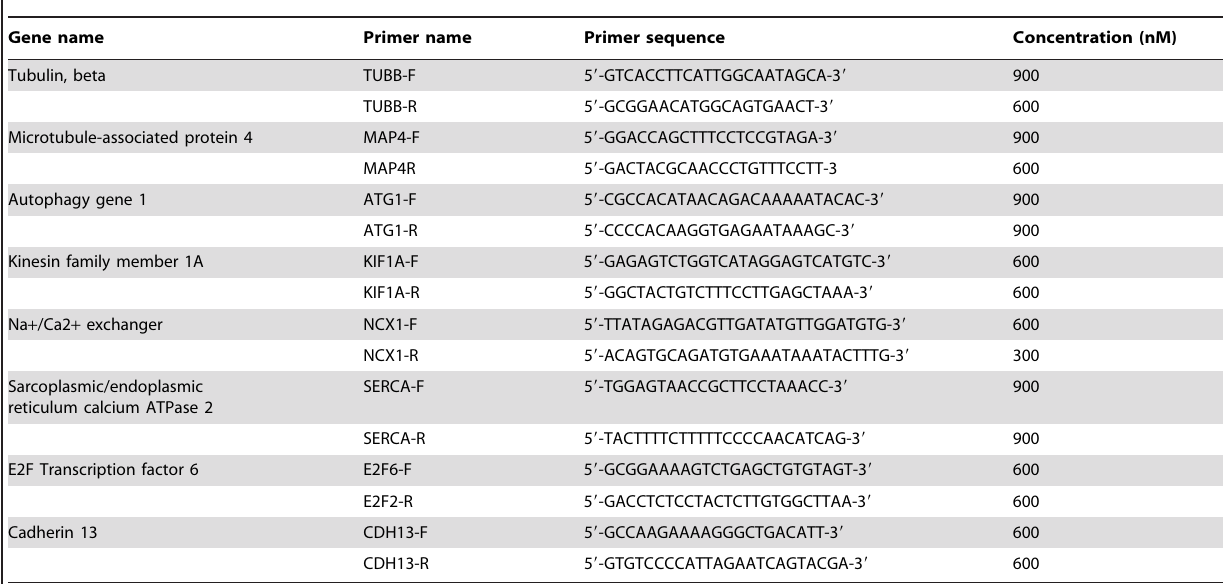
Table 2. Primer sequences for Q-PCR validation of selected